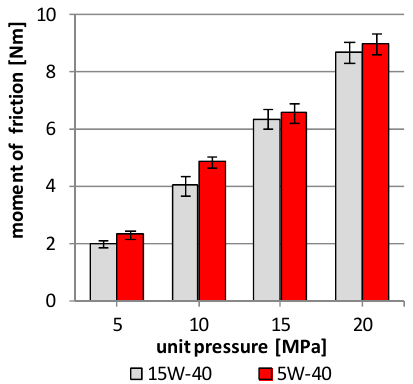
Figure 4. Moment of friction during start-up of the pair vs unit pressure when lubricating with 15W-40 mineral engine oil and 5W-40 synthetic engine oil.